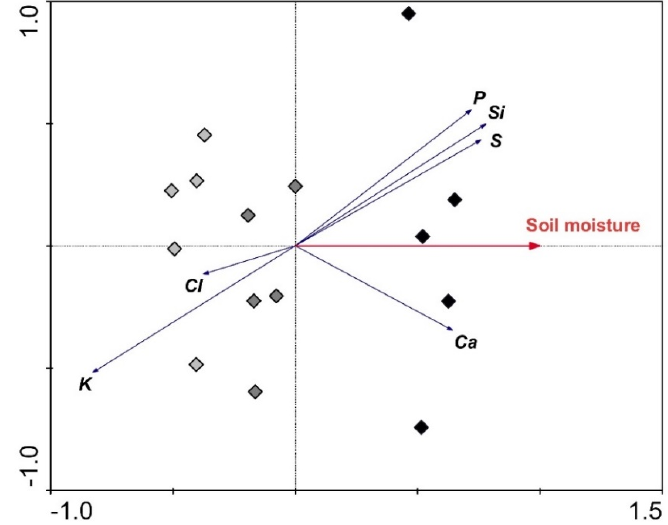
Figure 7. The redundancy analysis plot showing the strengths of the associations between soil moisture and leaf element contents. Black diamonds, WW; dark grey diamonds, MWS; light grey diamonds, SWS.